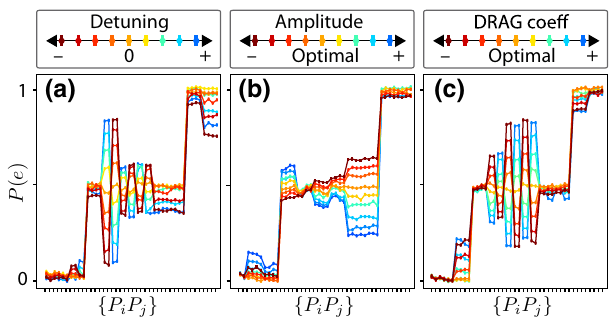
FIG. 11. Example of an ALLYX measurement . The out- come of a typical ALLXY experiment with 21 combinations of one or two single-qubit rotations around the x and y axes by an angle of π/ 2 or π applied on a qubit before the measurement of its state, i.e., { P i P j } ⊆ { I , X ( 90 ) , Y ( 90 ) , X ( 180 ) , Y ( 180 ) } . The sequence is designed to highlight the different error syndromes of a single-qubit rotation, such as (a) detuning from resonance, (b) variations in drive amplitudes, and (c) variations in the coefficient of the ALLXY